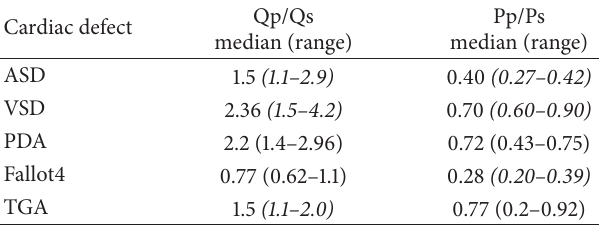
Table 2: Median of Qp/Qs and Pp/Ps in different cardiac lesions.